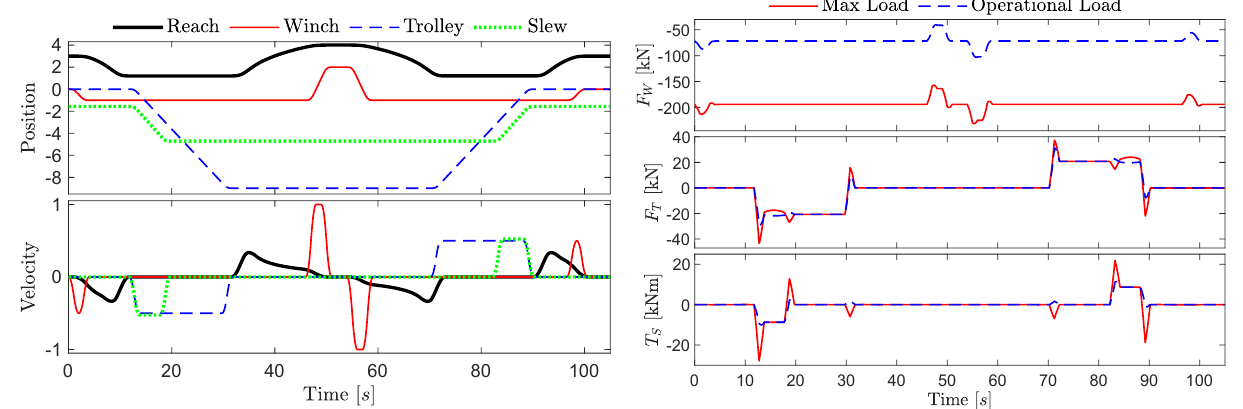
Figure 15: Generated motion trajectories: (top) position Figure 17: Actuator load cycle at max load and operational reference x R [ m ], x W [ m ], x T [ m ], and θ S [ rad ]; load: (top) winch; (middle) trolley; (bottom) ], v W [ m ], (bottom) velocity reference v R [ m slew. s s v T [ m ], and ω S [ rad ]. s s